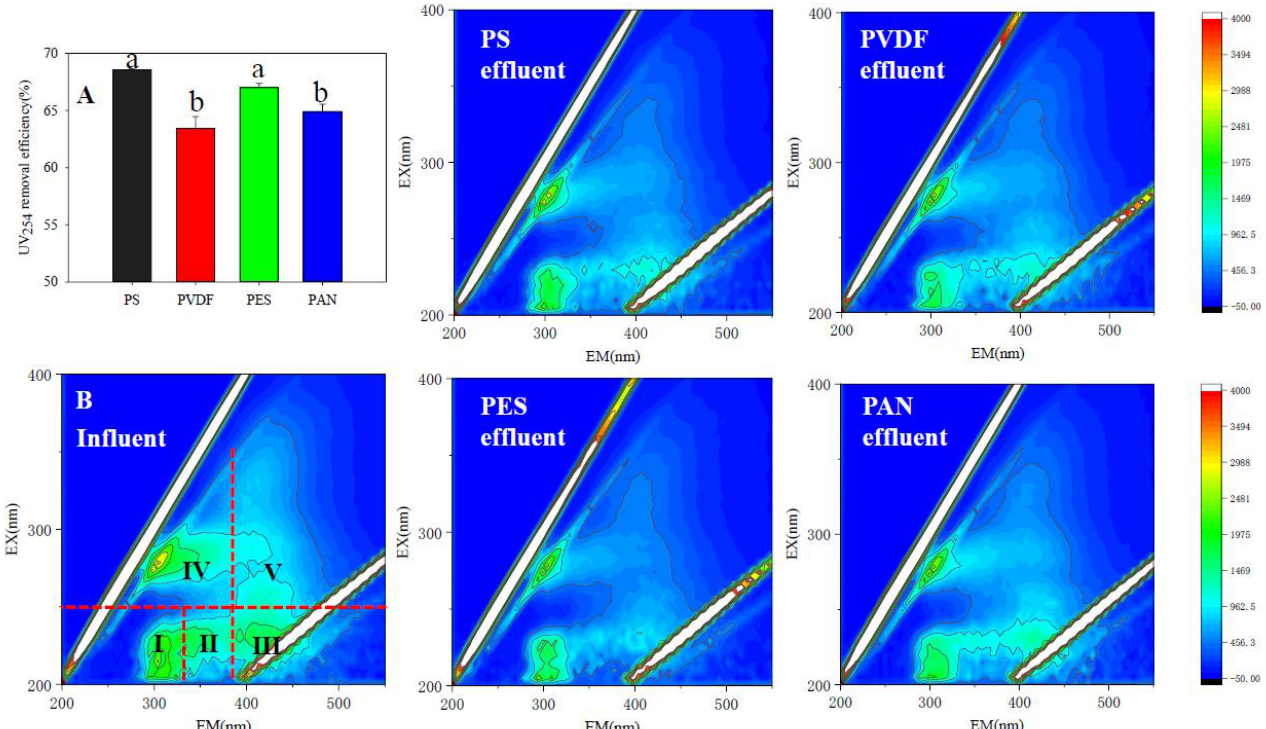
Figure 3. UV 254 removal rates of UF membranes: ( A ) With different membrane characteristics ( a,b —Values followed by the same letter are not significantly different at p < 0.05 ); ( B ) 3D-EEM profiles (Region I: simple aromatic proteins I; Region II: aromatic proteins II; Region III: fulvic acid-like substances; Region IV: soluble microbial by-product-like substances; Region V: humic acid-like substances). Table 6. The integral standard volume of the fluorescence region before and after ultrafiltration using different membrane materials.